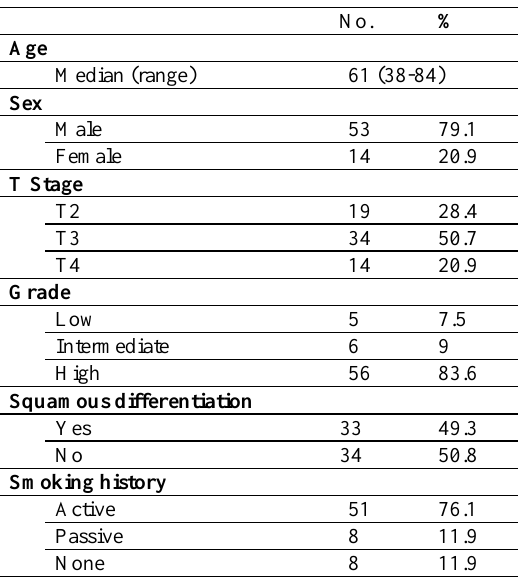
Table 1: Characteristics of 67